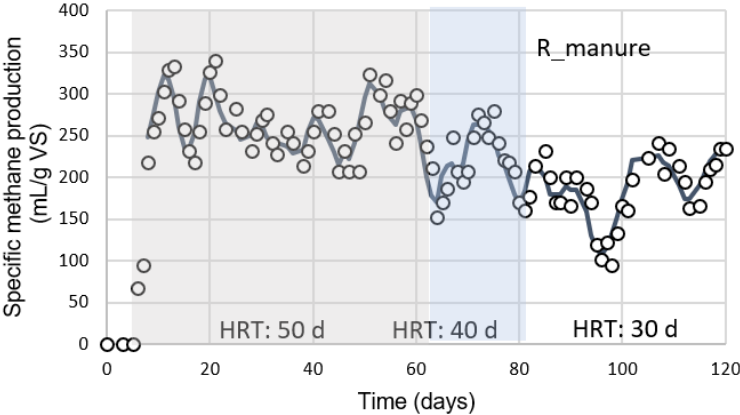
Figure 5. Evolution of methane production obtained from reactor treating sheep manure as a single substrate.